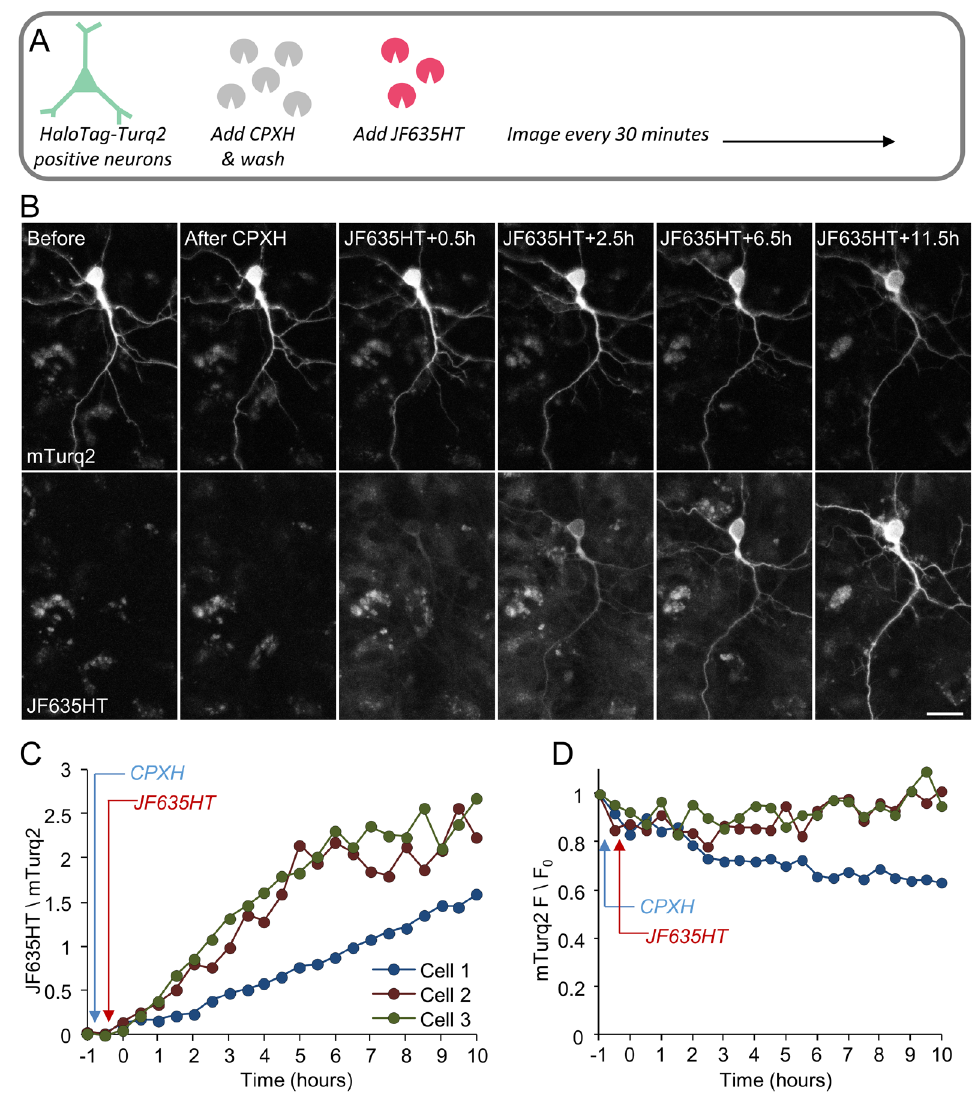
Figure 4. CPXH improves the reliability of newly synthesized protein detection in living cells. ( A ) Neurons expressing HaloTag-mTurq2 were first treated with CPXH (10 µM) for 30 minutes. The cells were then washed, followed by addition of JF635HT to the cell culture media (100nM, without washing it out), and the cells were followed by time-lapse imaging. ( B ) Example of mTurq2-positive cortical neuron (17 days in culture) treated as described in A and followed by time lapse imaging. Bar, 20µm. ( C ) Changes in JF635HT labeling over time were quantified by measuring, on a cell-by-cell basis, the ratio of JF635HT to mTurq2 fluorescence in mTurq2-positive cells. Background corrected JF635HT/mTurq2 fluorescence ratios for three different neurons are shown. Images in B belong to Cell 1. Note the negligible labeling immediately after exposure to JF635HT (compare with Figure 3B). ( D ) mTurq2 fluorescence in the same cells, expressed as a fraction of each cells initial